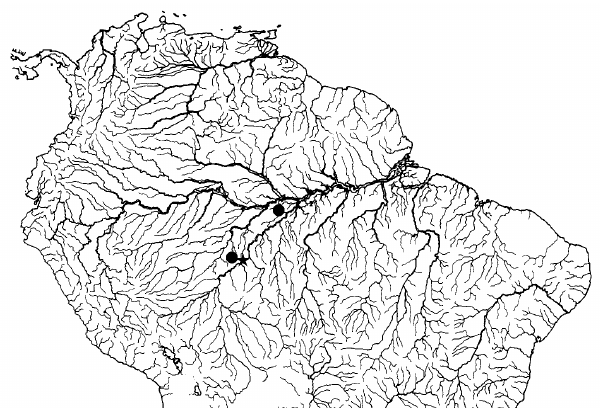
Fig. 8. Distribution of Amazonspinther dalmata in northern South America, rio Purus and rio Madeira basins. Circles represent more than one lot, and more than one locality. Star indicates the type locality.